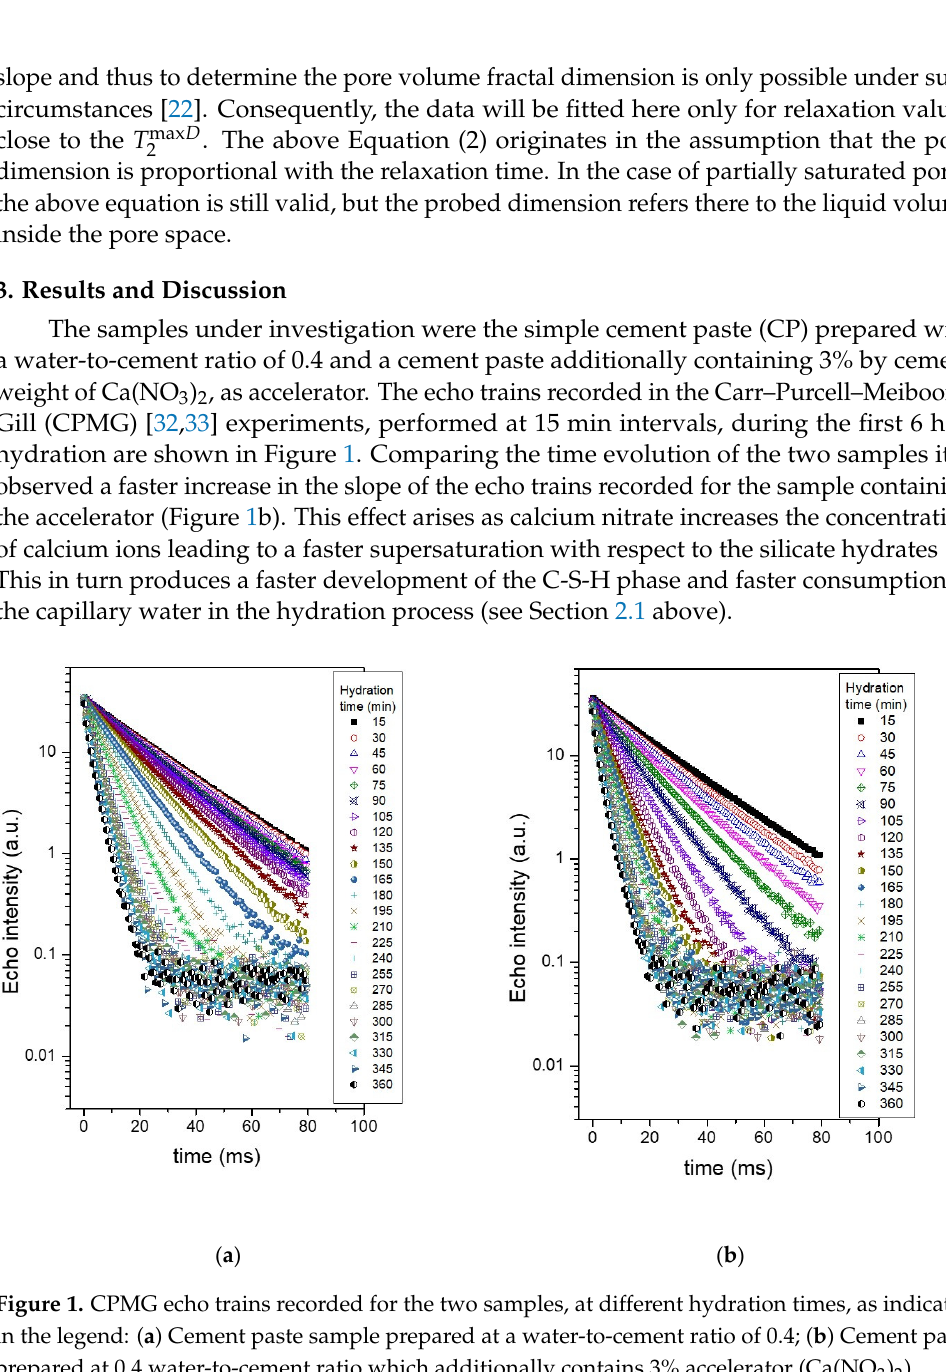
Figure 2. Relaxation time distributions for the two samples, at different hydration times, as indicated in the legend: ( a ) Cement paste sample prepared at a water-to-cement ratio of 0.4. ( b ) Cement paste prepared at 0.4 water-to-cement ratio which additionally contains 3% accelerator (Ca(NO 3 ) 2 ), by cement mass. The third peak (the largest one) in the relaxation time distributions, shown in Figure 2, corresponds to the capillary water contained between the cement grains during the first stage of hydration and will be monitored here in more detail. The area of the peak is pro- portional with the amount of water inside the capillary pores. Figure 3 shows the depend- ence of the peak area (Figure 3a) and of the position of the peak maximum (Figure 3b) on